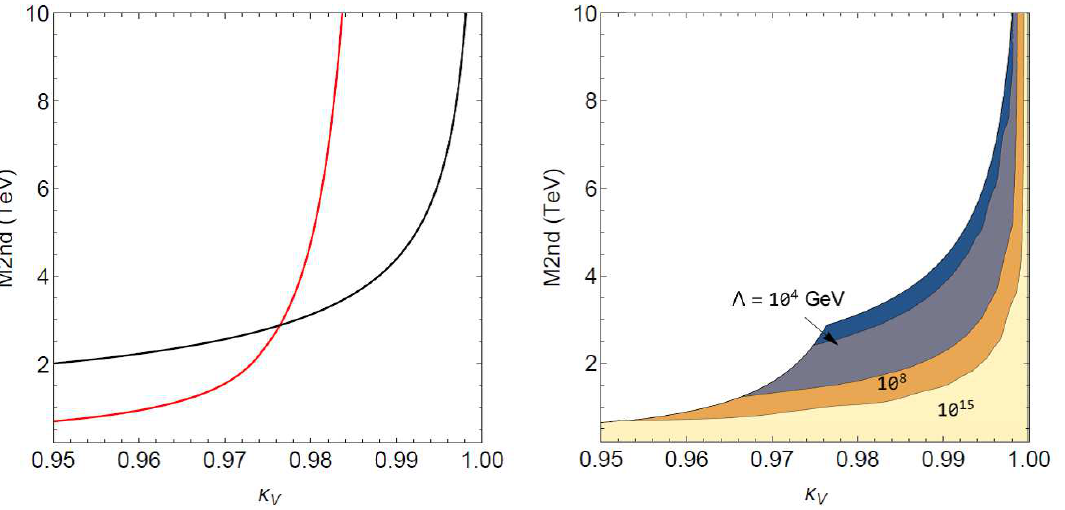
Figure 1 . Bounds on M 2nd = m in the HSM as functions of κ V = g hVV /g SM hvv . On the left panel, H S we show the upper limit on M 2nd given by the tree level perturbative unitarity and the vacuum stability constraints (black line) and that given by the electroweak S and T parameters (red line). On the right panel, the upper limit on M 2nd is shown by imposing Bound B, where the cutoff of the theory is shown as contours on this plane.